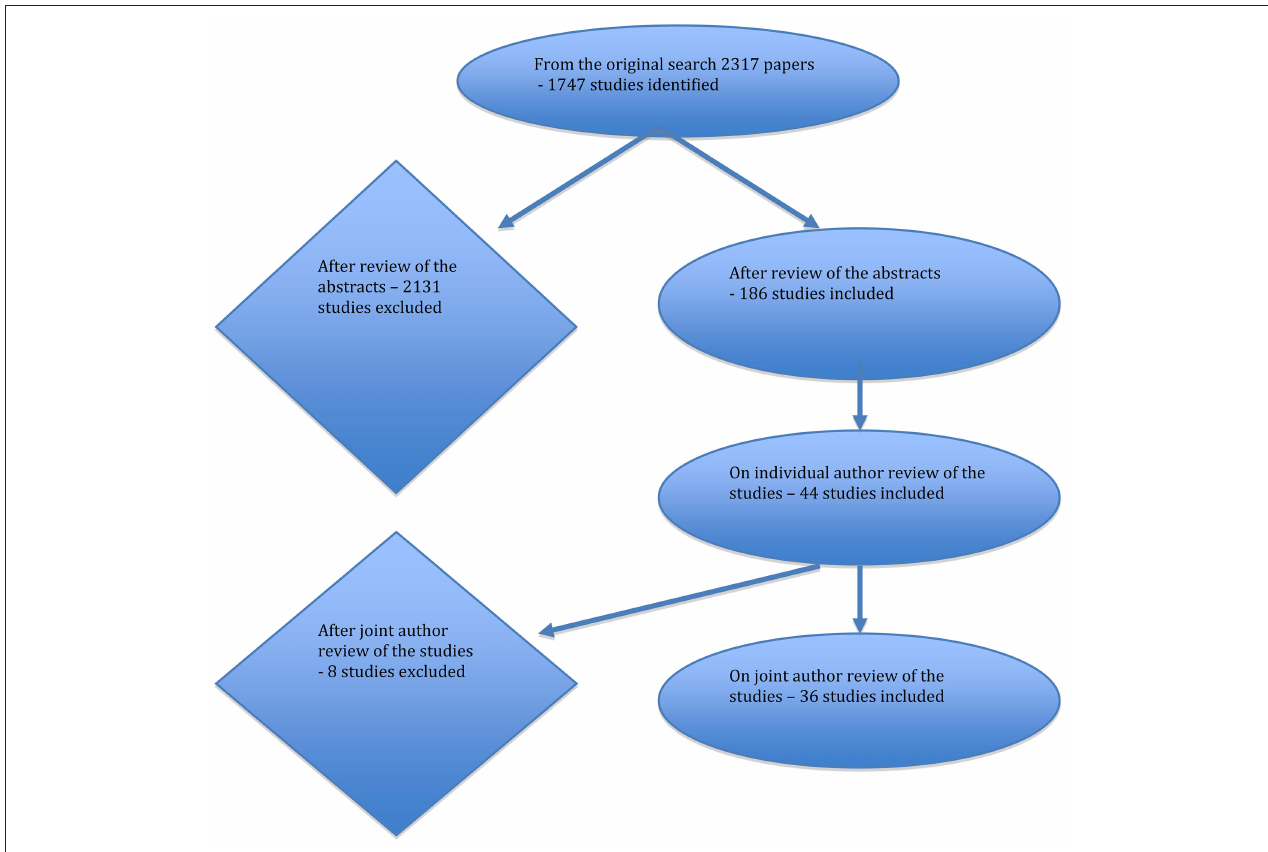
FIGURE 1 | Flow of literature search